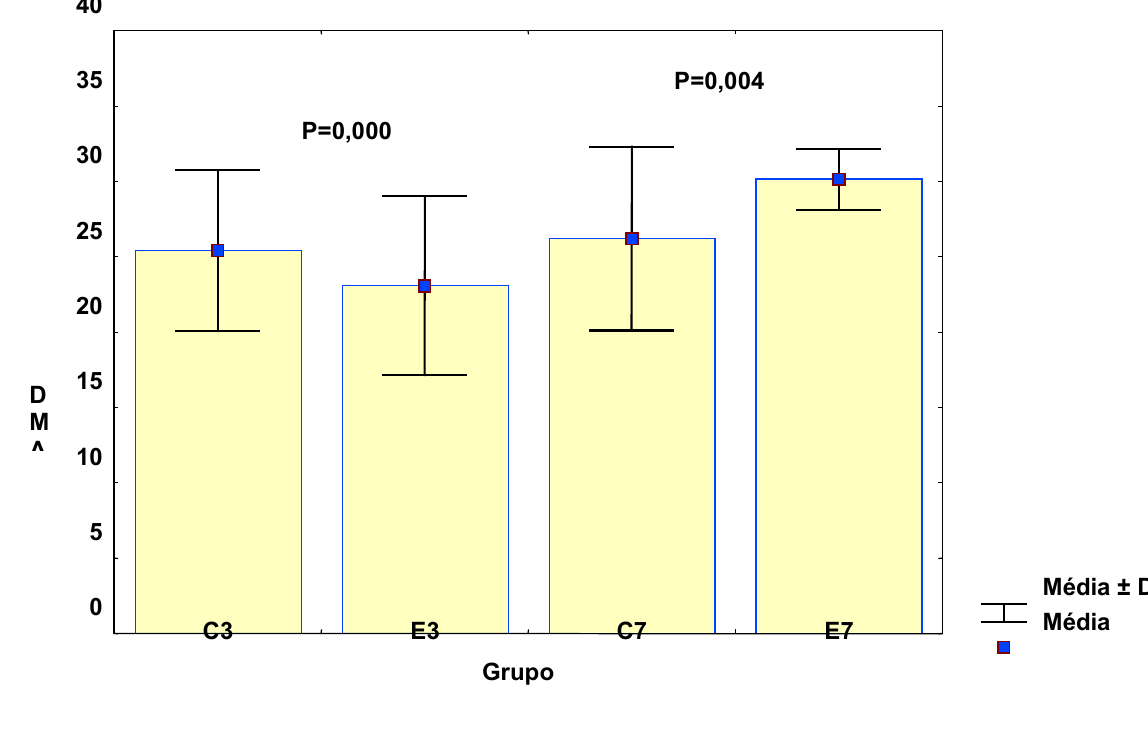
FIGURA 6 – Variável Dmax com média e desvio padrão para os grupos controle e experimento. Legenda: C3 = GC3D, E3 = GE3D, C7 = GC7D, E7 = GE7D